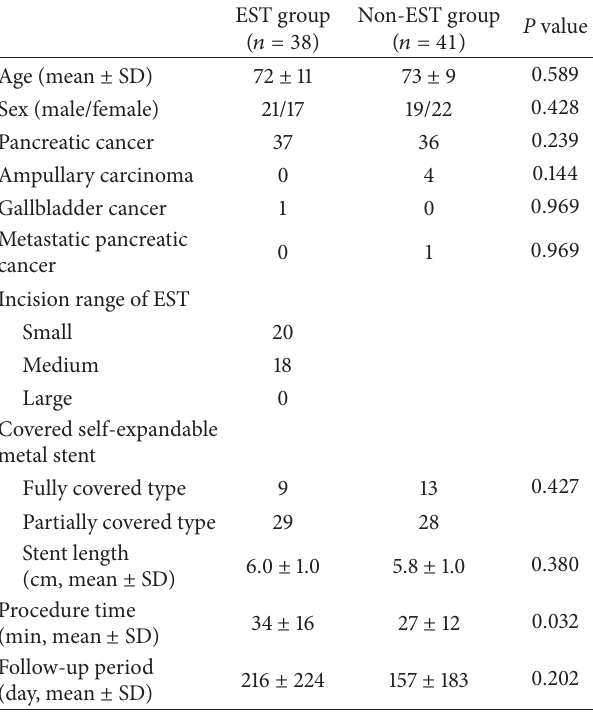
Table 1: Patient characteristics.